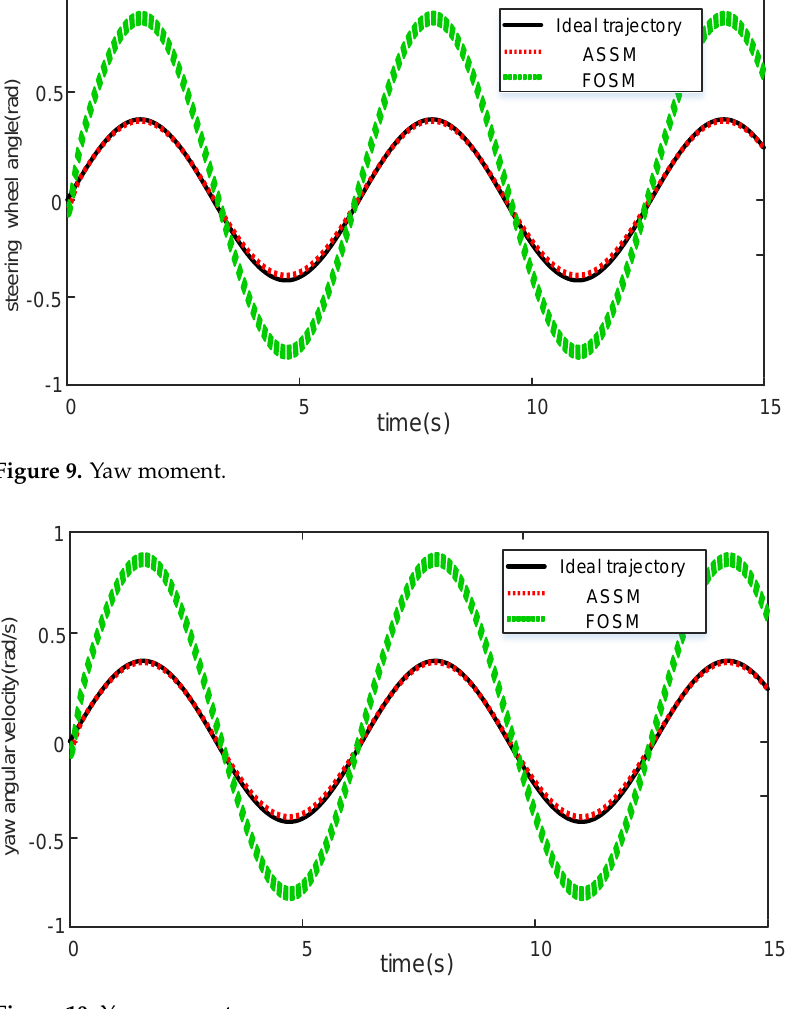
Figure 11. Yaw moment. In summary, among the various working conditions, high-speed working conditions on low-adhesion roads are the most dangerous working conditions, but the designed con- trol system can effectively control the heading deviation and lateral deviation in vehicle trajectory tracking while ensuring the lateral stability of the vehicle. 5. Conclusions 1.